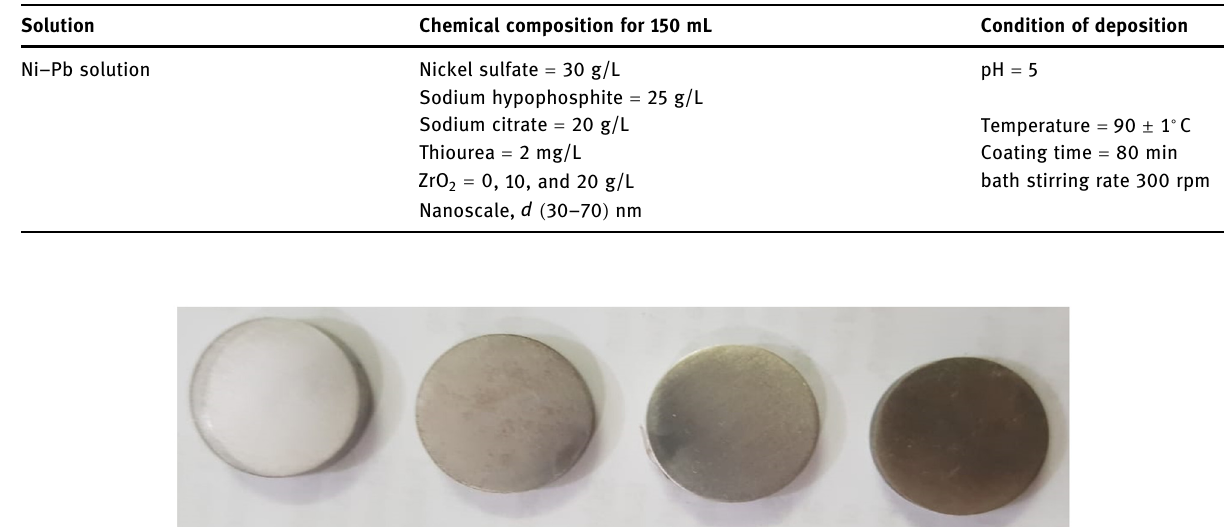
Table 2: Components of an electroless solution [ 25 ]